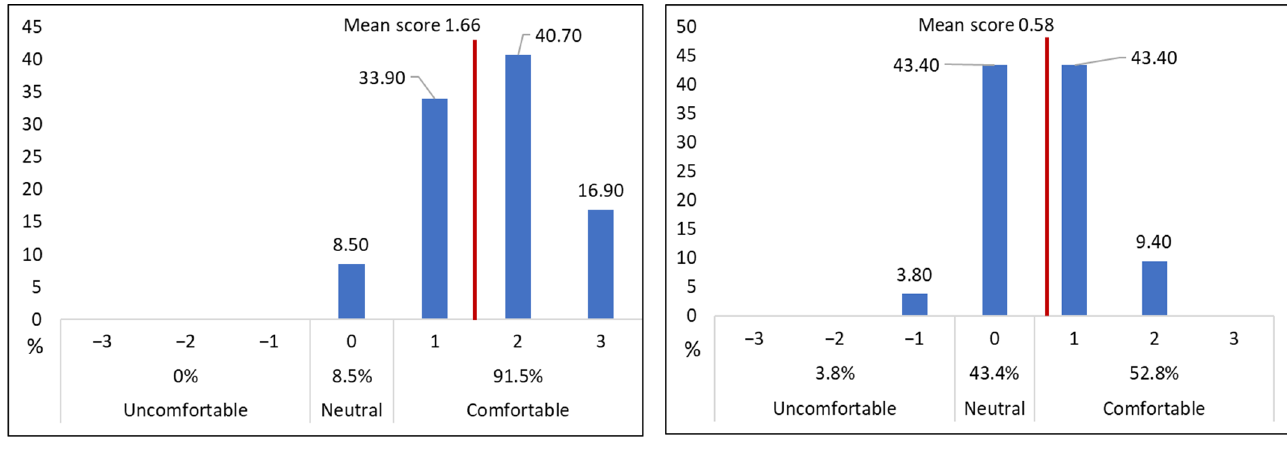
Figure 4. Frequency distribution of occupants’ vote for overall comfort.